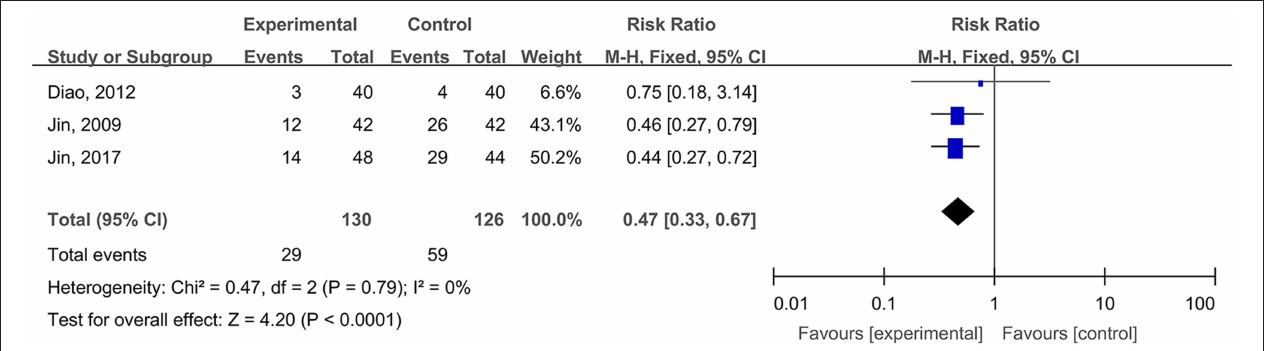
FIGURE 13 | Comparative meta-analysis of the incidence rates of adverse reactions of burn wound-affected patients.